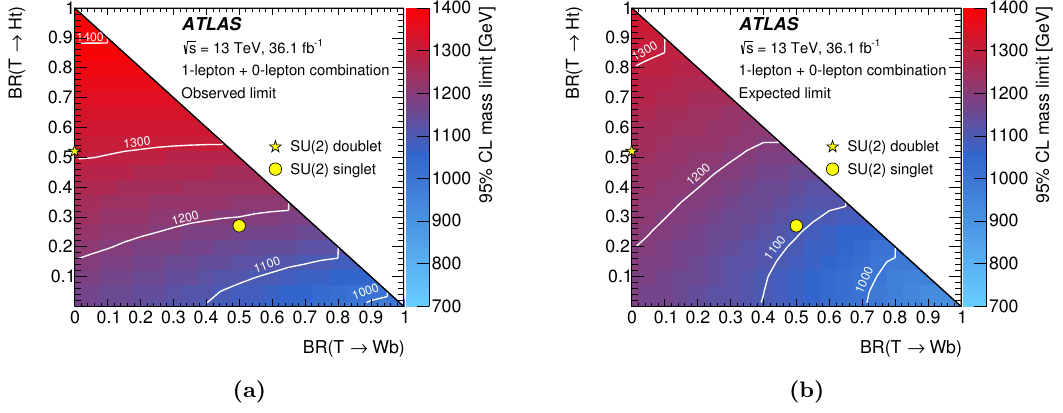
Figure 19. (a) Observed and (b) expected limit (95% CL) on the mass of the T quark in the plane of ( T Ht ) versus ( T Wb ) for the combination of the 1-lepton and 0-lepton searches. In the B ! B ! (cid:12)gure, the branching ratio is denoted \BR". The background estimate used in the computation of the limits is the result obtained from the background-only (cid:12)t to data. Contour lines are provided to guide the eye. The yellow markers indicate the branching ratios for the SU(2) singlet and doublet scenarios with masses above 800 GeV, where they are approximately independent of the (cid:25) T quark mass.